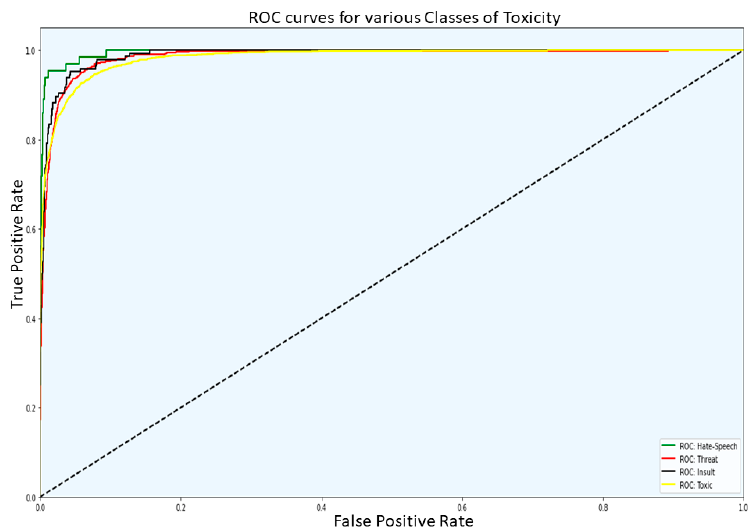
Figure 13. ROC curves of the predictions made for different types of Toxic content.